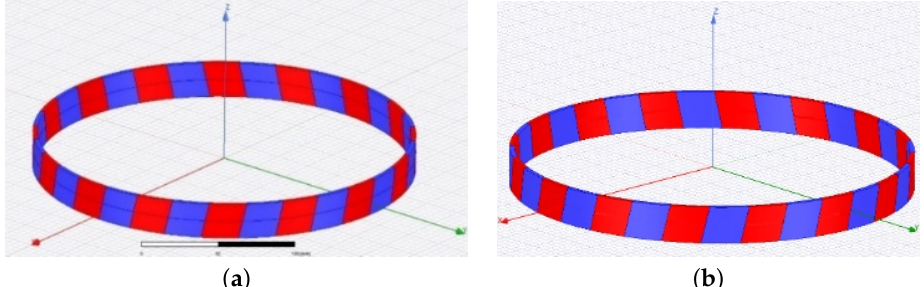
Figure 5. ( a ) Segmented skewed magnets. ( b ) Nonsegmented skewed